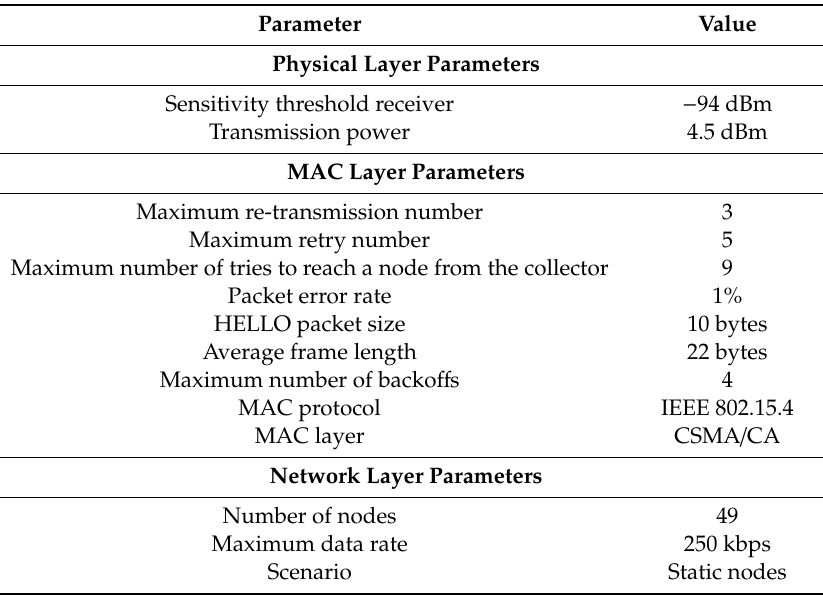
Table 1. Employed parameters in the network simulation. CSMA / CA, carrier sense multiple access with collision avoidance [52].